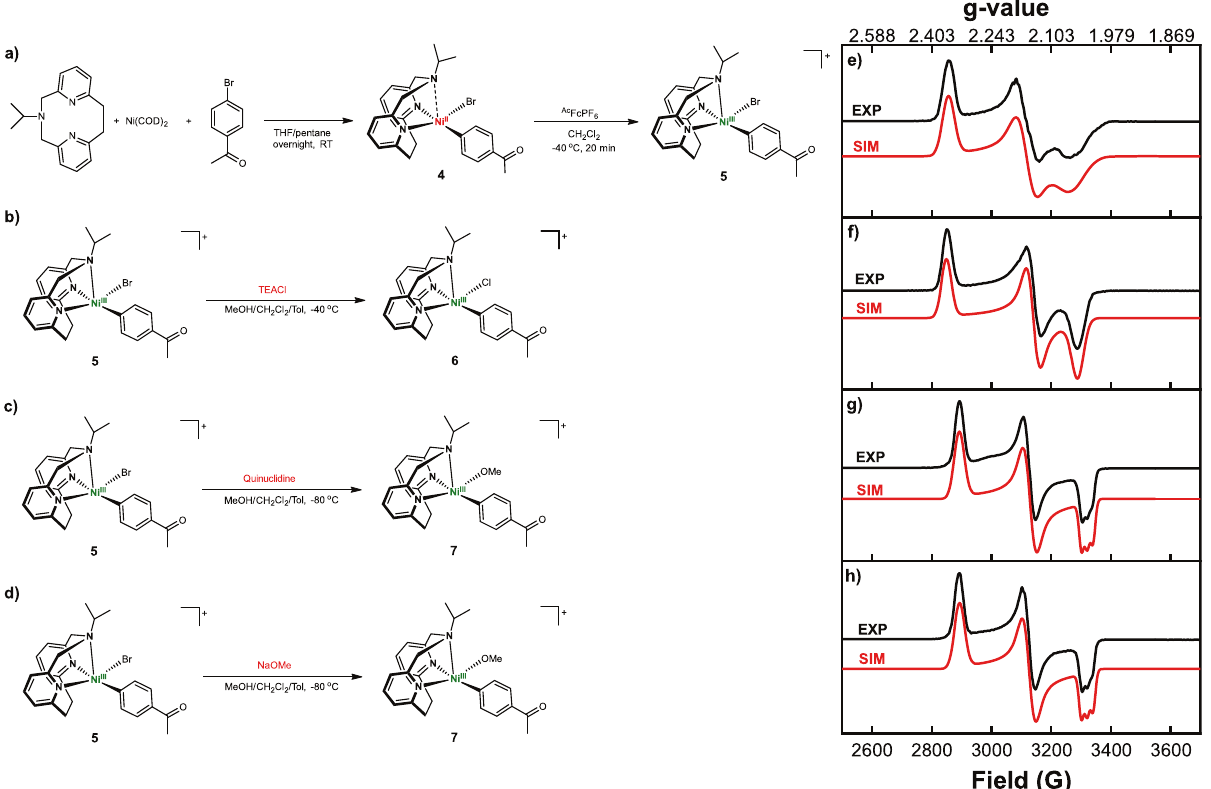
Fig. 5 EPR studies of Ni III species. (left) Experimental setup for the synthesis of ( iPr N3)Ni II (PhAc)Br (4) and EPR detection of a [( iPr N3)Ni III (PhAc)(Br)] + (5), b [( iPr N3)Ni III (PhAc)(Cl)] + (6), and c and d [( iPr N3)Ni III (PhAc)(OMe)] + (7). (right) Experimental (black) and simulated (red) EPR spectra of the reaction mixtures recorded at 77 K in 1:1:3 MeOH:CH 2 Cl 2 :Toluene frozen glass: e [( iPr N3)Ni III (PhAc)(Br)] + (5), f [( iPr N3)Ni III (PhAc)(Cl)] + (6), and g and h [( iPr N3)Ni III (PhAc)(OMe)] + (7). The following parameters were used for simulation of e g x = 2.356, g y = 2.158, g z = 2.059; f g x = 2.363, g y = 2.144, g z = 2.047; g g x = 2.326, g y = 2.151, g z = 2.027 (A z (N) = 19.4 G); h g x = 2.326, g y = 2.152, g z = 2.027 (A z (N) = 19.5